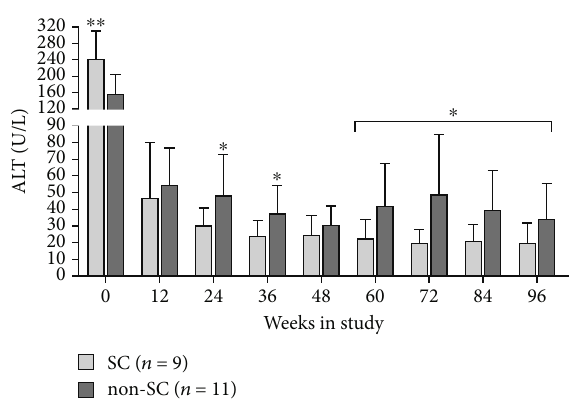
Figure 4: Dynamic change of ALT levels in CHB subjects with HBeAg seroconverting (SC) and non-SC during TDF treatment for 96 weeks. ∗ P < 0 : 05 and ∗∗ P < 0 : 01 , the ALT levels in HBeAg SC subjects were compared to those in non-SC subjects at the same treatment time point. Statistical analysis uses nonparametric